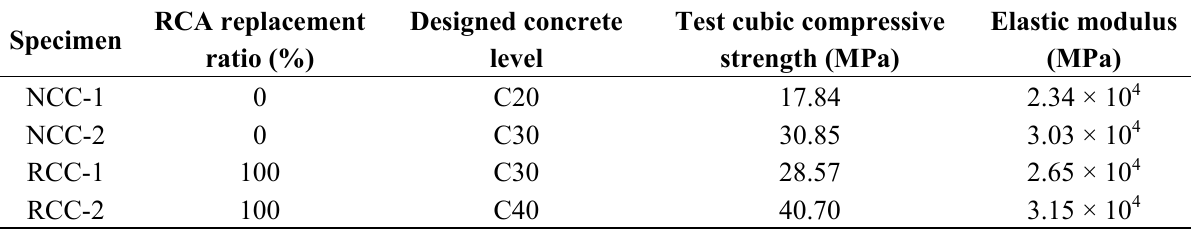
Table 2. Concrete mechanical properties as